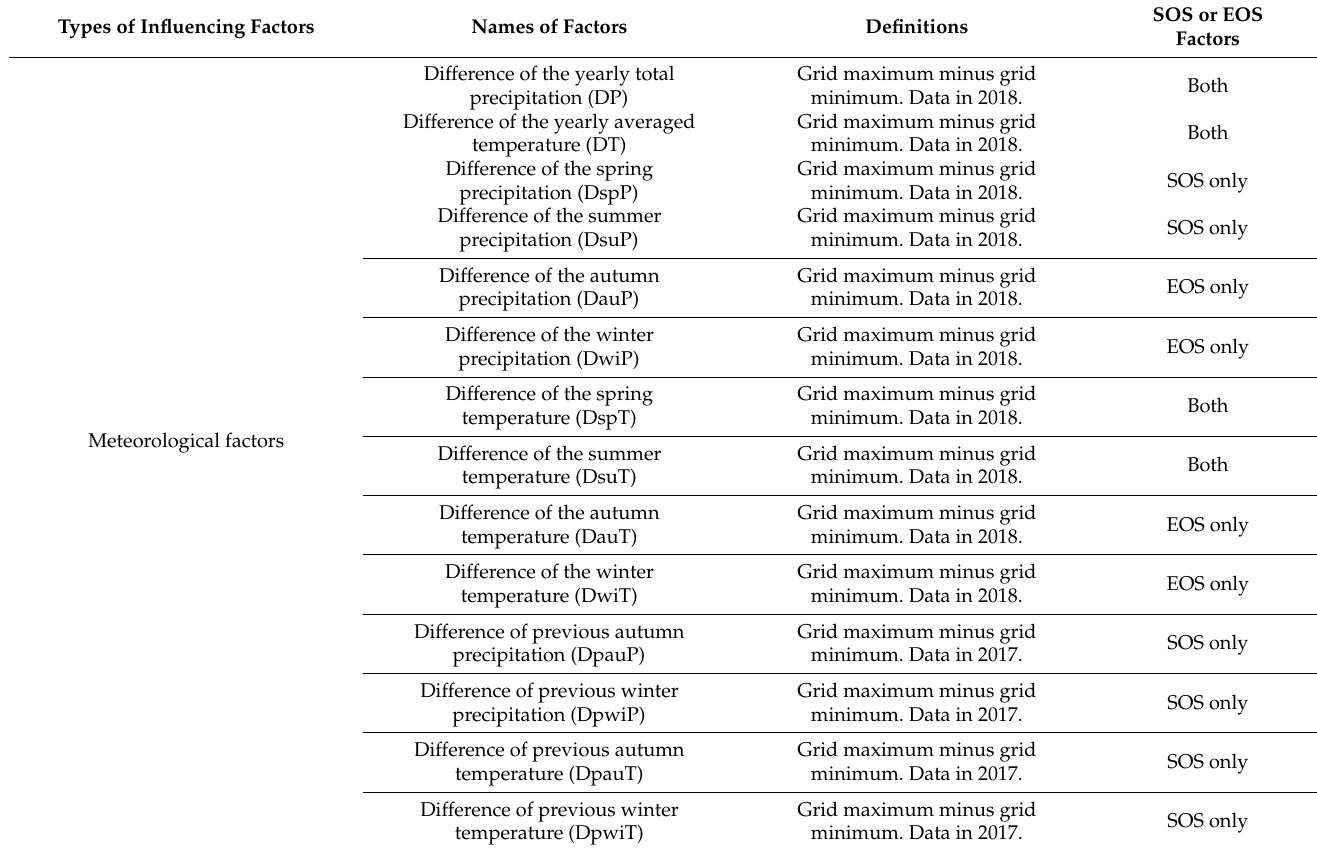
Table 2. Names and definitions of the influencing factors considered in this